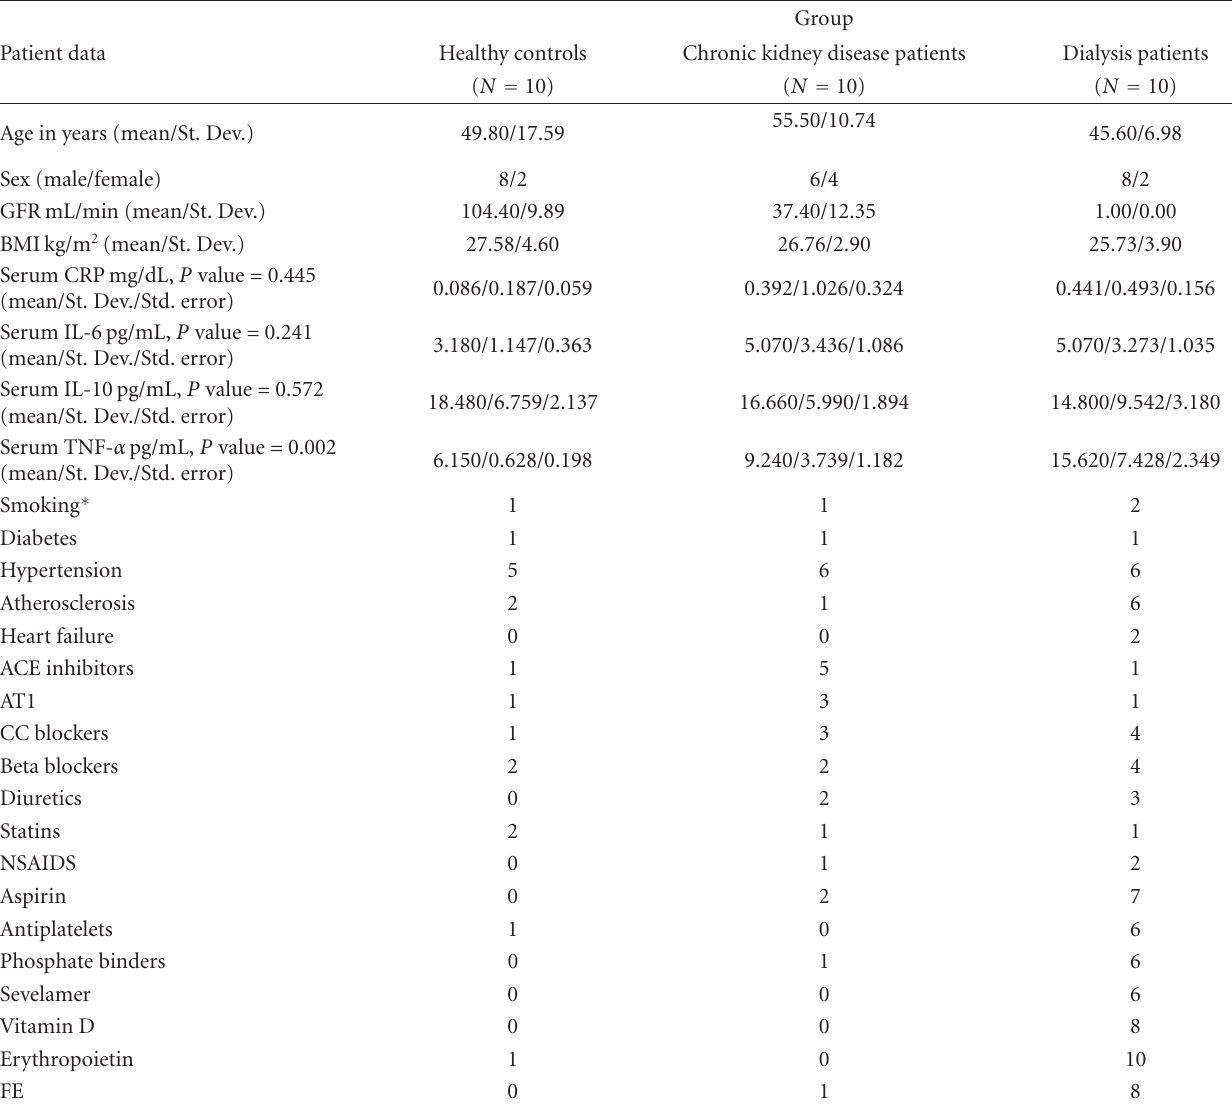
Table 1: Demographic data, inflammation markers, chronic health disorders, and pharmaceutical therapy of the populations included in the study.